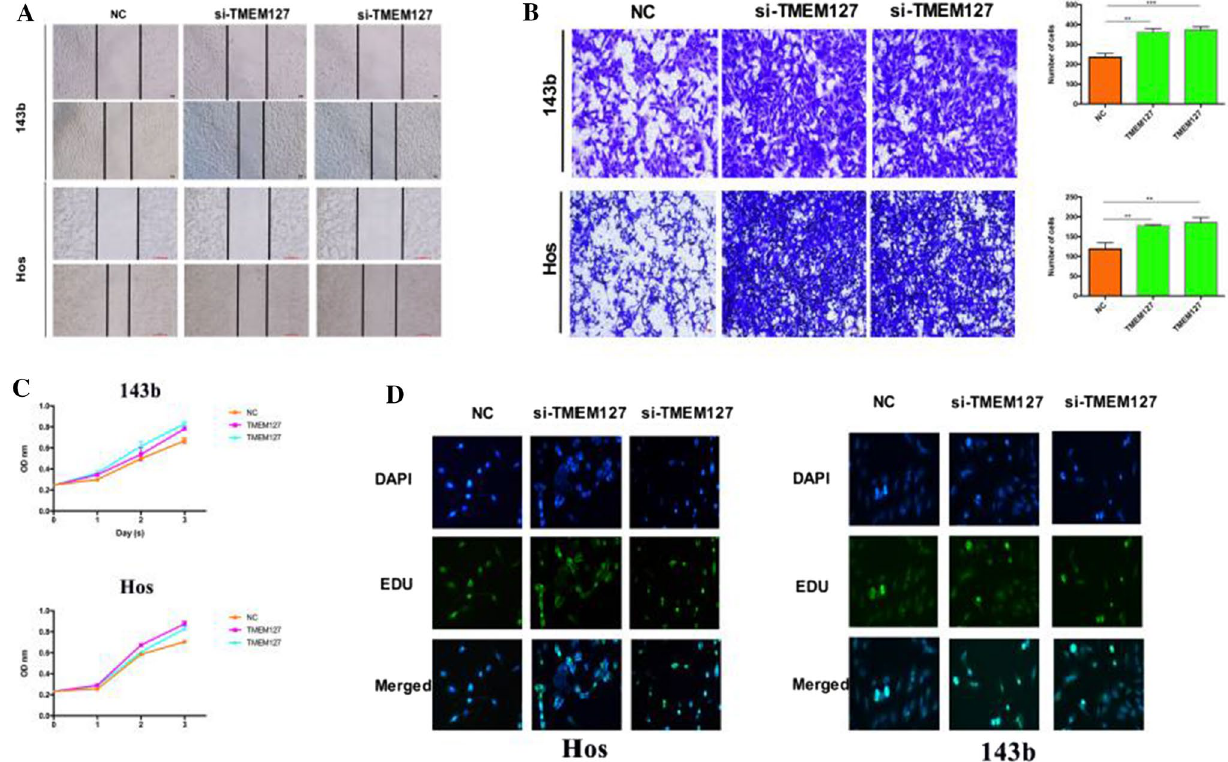
Fig. 4 miR-23b-5p promotes OS progression through TMEM127. A The migration ability of OS cells was analyzed by wound healing assay. B Transwell assay to detect the invasion level of OS cells. C Cell viability of 143b and Hos after transfection of siTMEM127 detected by CCK-8. D Cell proliferation kit to detect the proliferation ability of 143b and Hos cells after transfection with